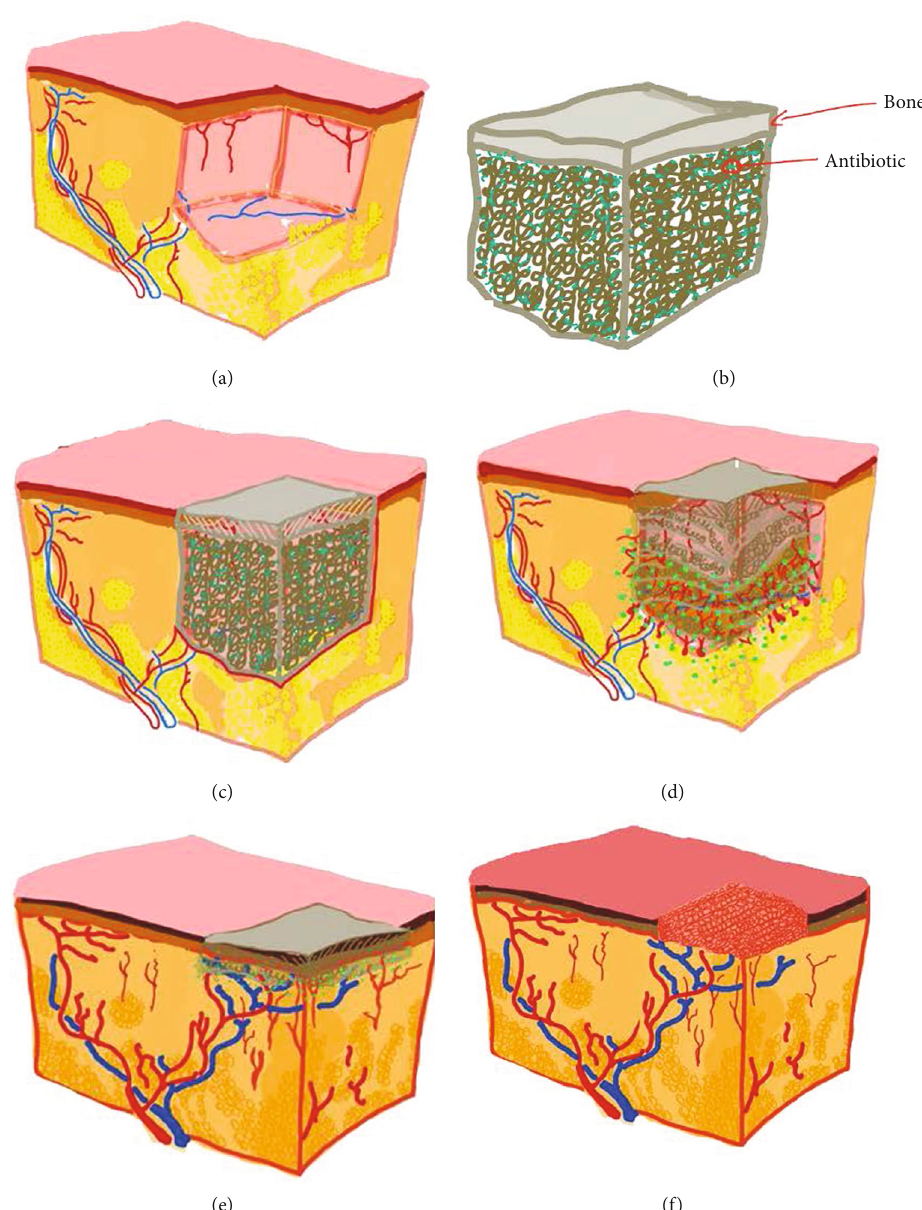
Figure 2: Schematic drawing of the antibiotic-loaded bone cement procedure. (a) Dermal defect. (b) Antibiotic-loaded bone cement. (c) Antibiotic-loaded bone cement was implanted into the defect site, and release of the antibiotic. (d) Fibroblast and vascular endothelial cells grow into the sca ff olds from the wound base and surrounding tissues, forming a new capillary cell complex. (e) After 3 weeks, the bone cement has degraded from the initial size, leaving only a remaining coat at the wound surface, covering a good granulated soft tissue. (f) The defect tissue was regenerated, living option for sutures or split thickness skin coverage of the